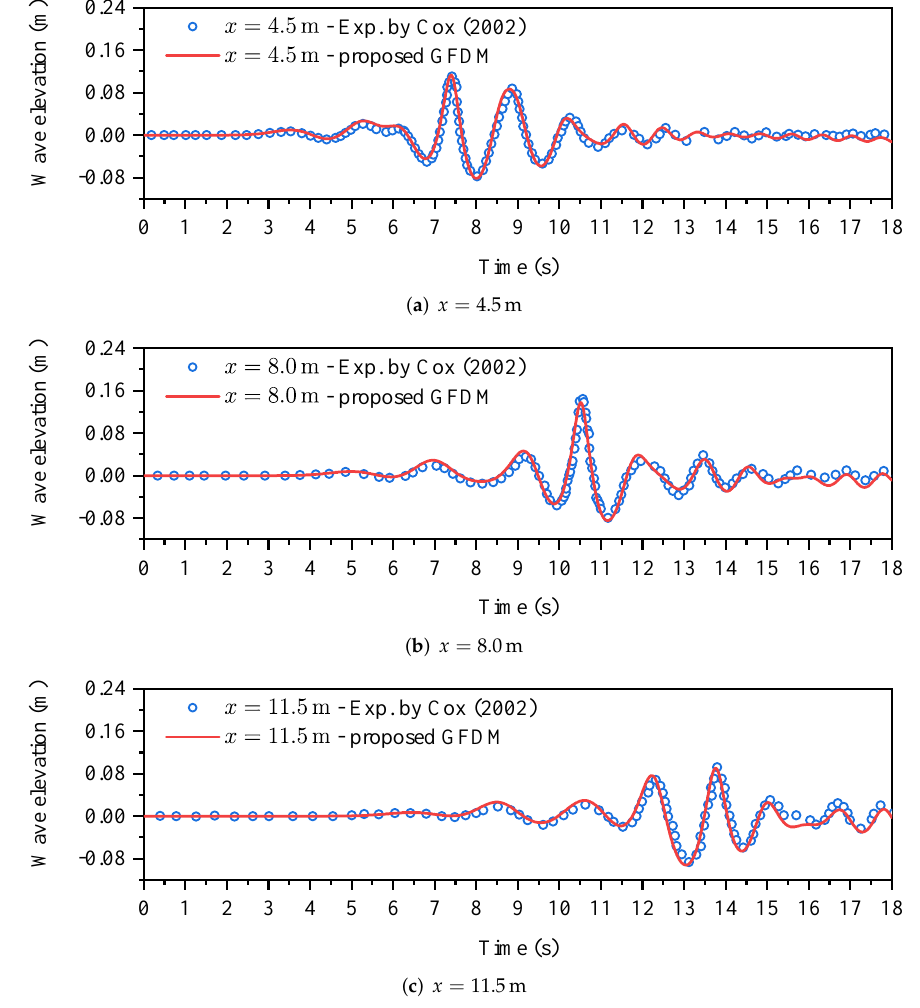
Figure 5. Comparison between numerical and experimental results at x = 4.5 m, 8.0 m, 11.5 m.